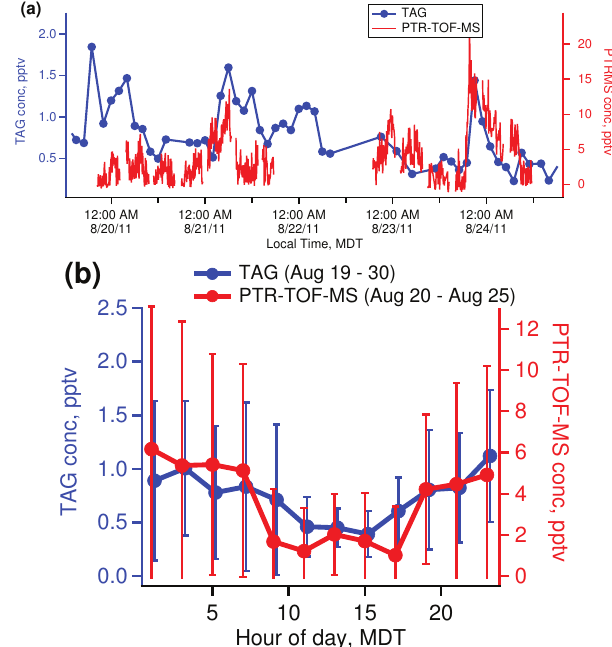
Figure 4. (a) Time series of SQT204 concentration measured by PTR-TOF-MS and by TAG during measurement overlap. (b) Diur- nal profile of SQT204 concentration during the entire measurement period of TAG (19–30 August) and PTR-TOF-MS (20 July–25 Au- gust). The markers represent the mean concentration and the error bars represent one standard deviation. The general diurnal trends between the two instruments agree qualitatively, but are not ex- pected to be quantitatively consistent owing to different sampling